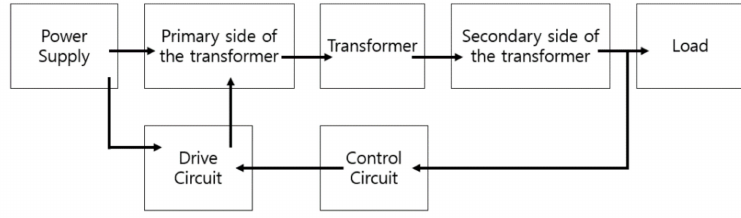
Figure 13. The designed block diagram of the proposed